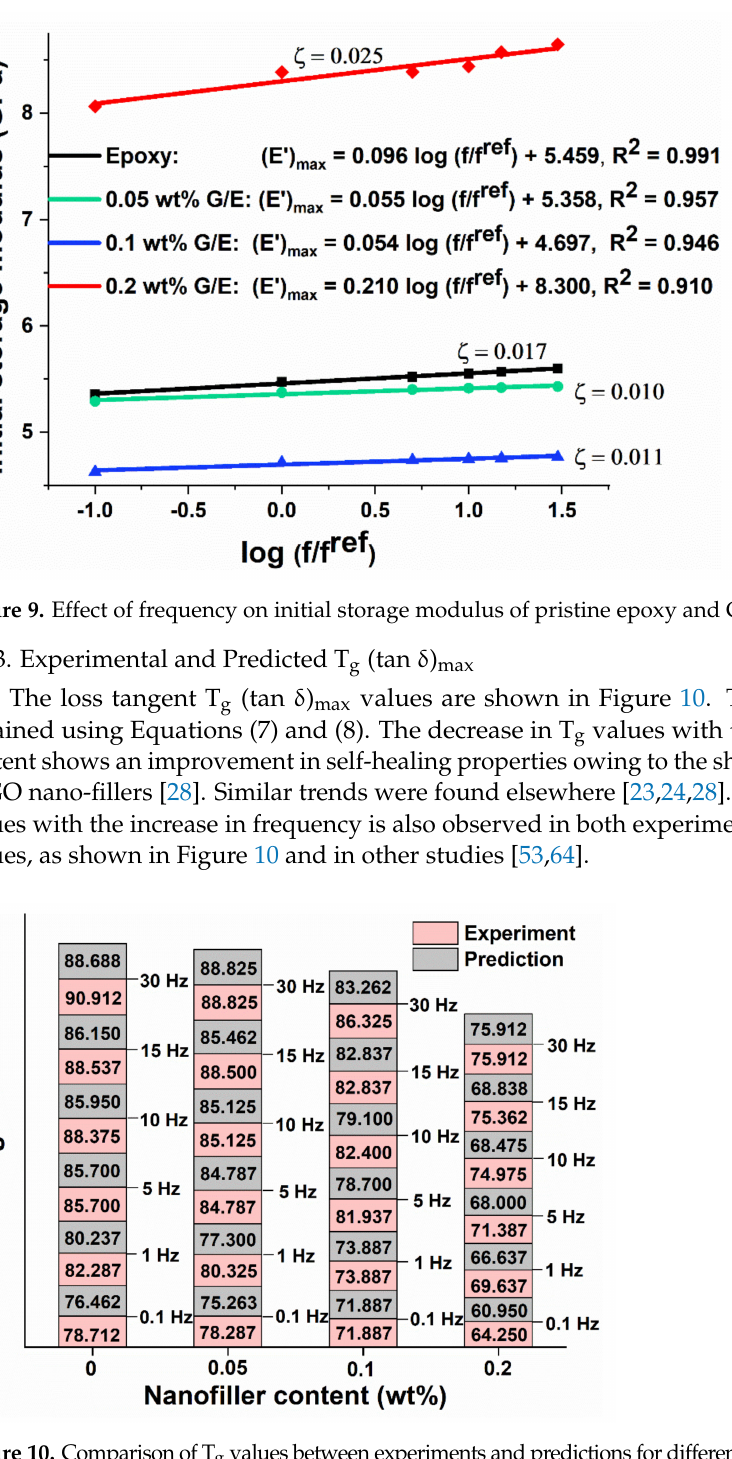
Figure 10. Comparison of T g values between experiments and predictions for different GO content